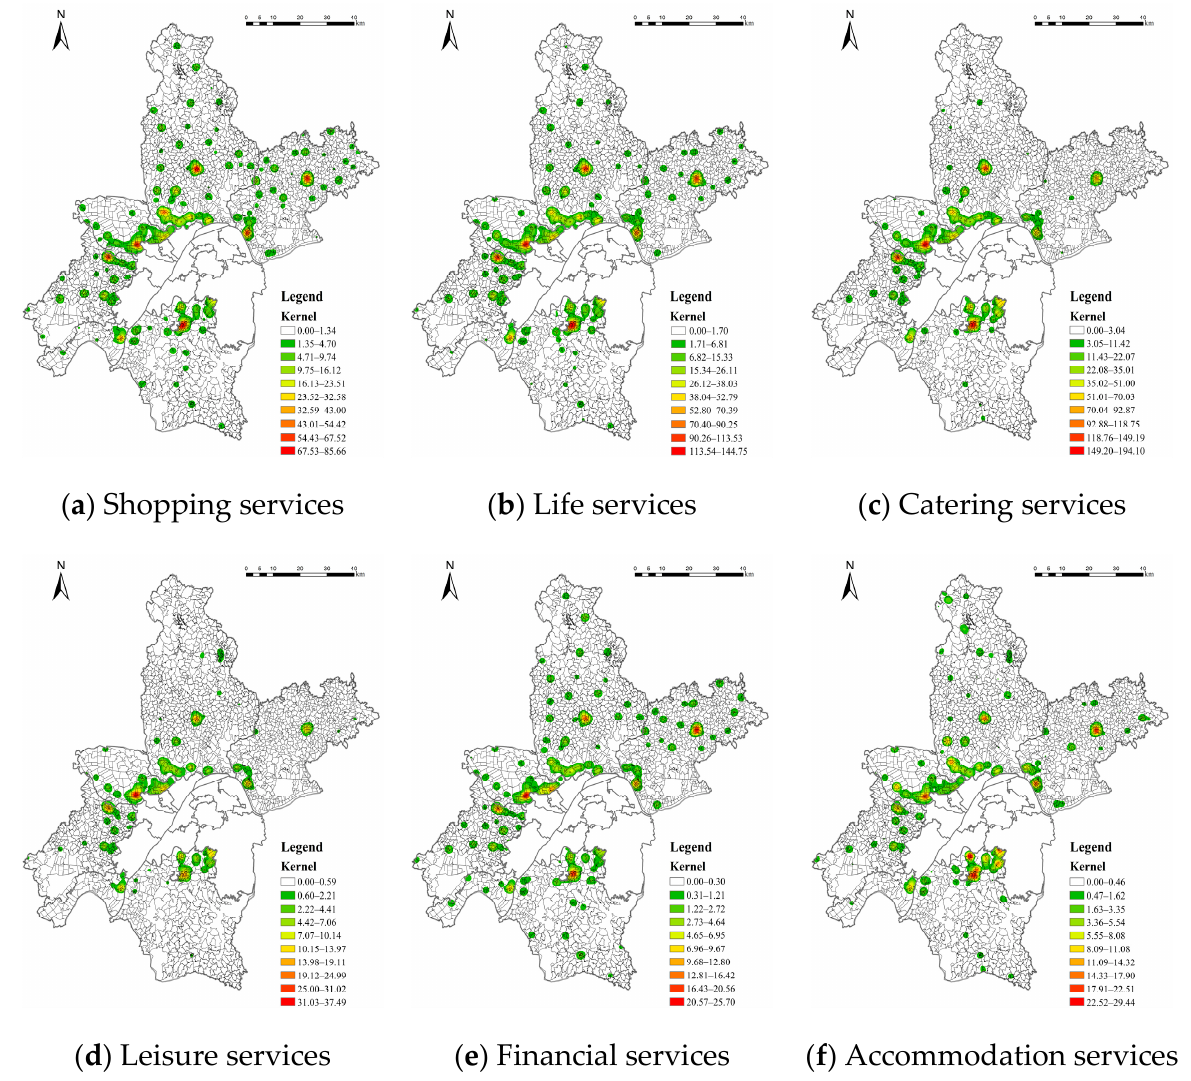
Figure 6. Kernel density of different types of market services industries in Wuhan city’s new urban districts. Table 6. The Moran’s I index of different types of market services industries in Wuhan city’s new urban